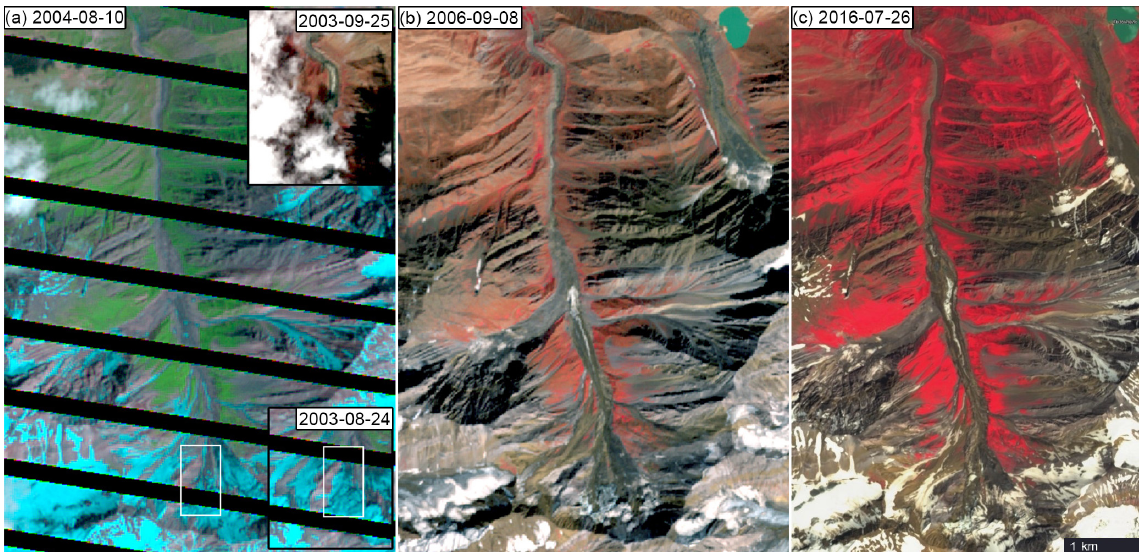
Figure A4. Mass flow events in the central Shuraki Kapali sub-catchment (a) L7 image 1 year after the sk-03 detachment (10 August 2004). The lower inset shows the pre-event image (24 August 2003); the ice-rich runout is shown in the upper inset (ASTER, 25 September 2003). (b) ASTER image of the sk-06 ice avalanches that broke off above the sk-03 detachment (8 September 2006). (c) S2 image of the sk-16a detachment (26 July 2016) that originated from the same location as sk-03. Landsat-7 and ASTER image courtesy of the US Geological Survey. Copernicus Sentinel data